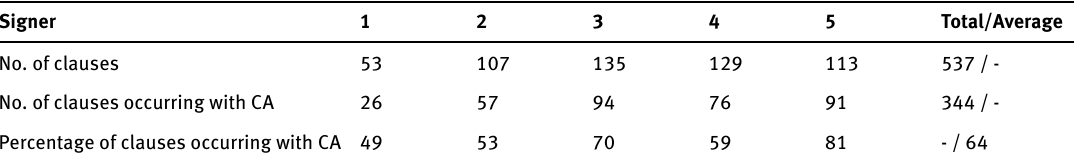
Table 3. Summary of clause–CA combinations.